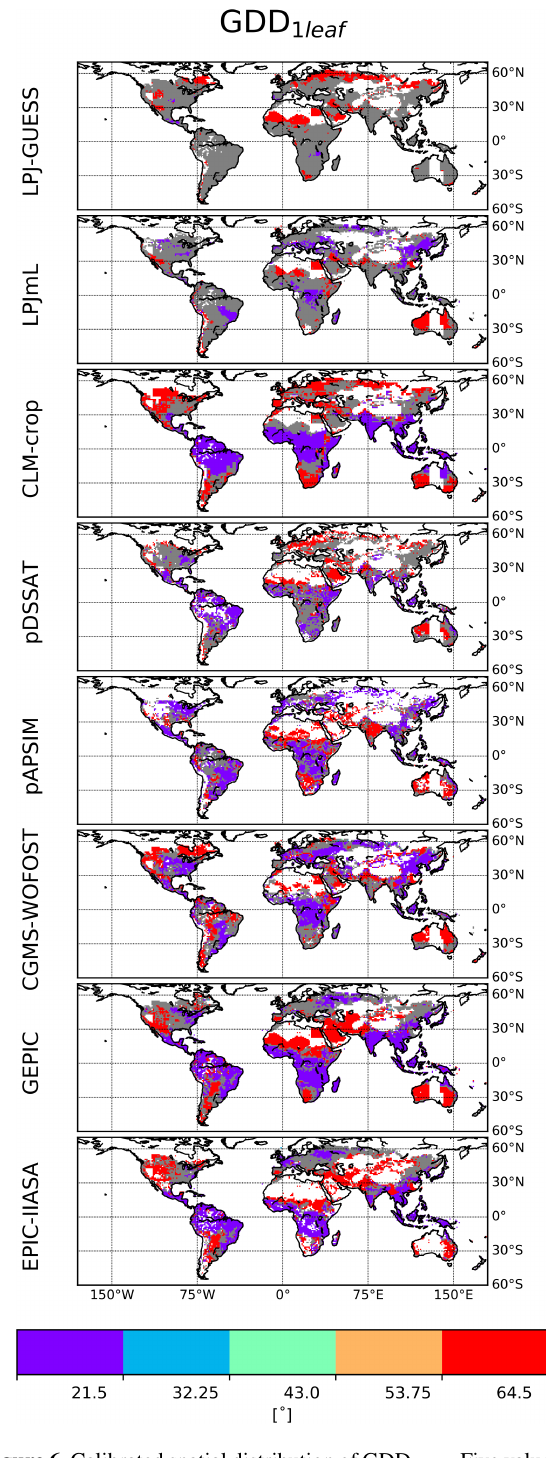
Figure 6. Calibrated spatial distribution of GDD 1leaf . Five values of GDD 1leaf are allowed (color scale and Table S1). Global GGCM- dependent ( C, RUE) have been calibrated prior to GDD 1leaf and for a given GGCM; grid cells for which calibrated GDD 1leaf is different for the four ( C , RUE) pairs are in